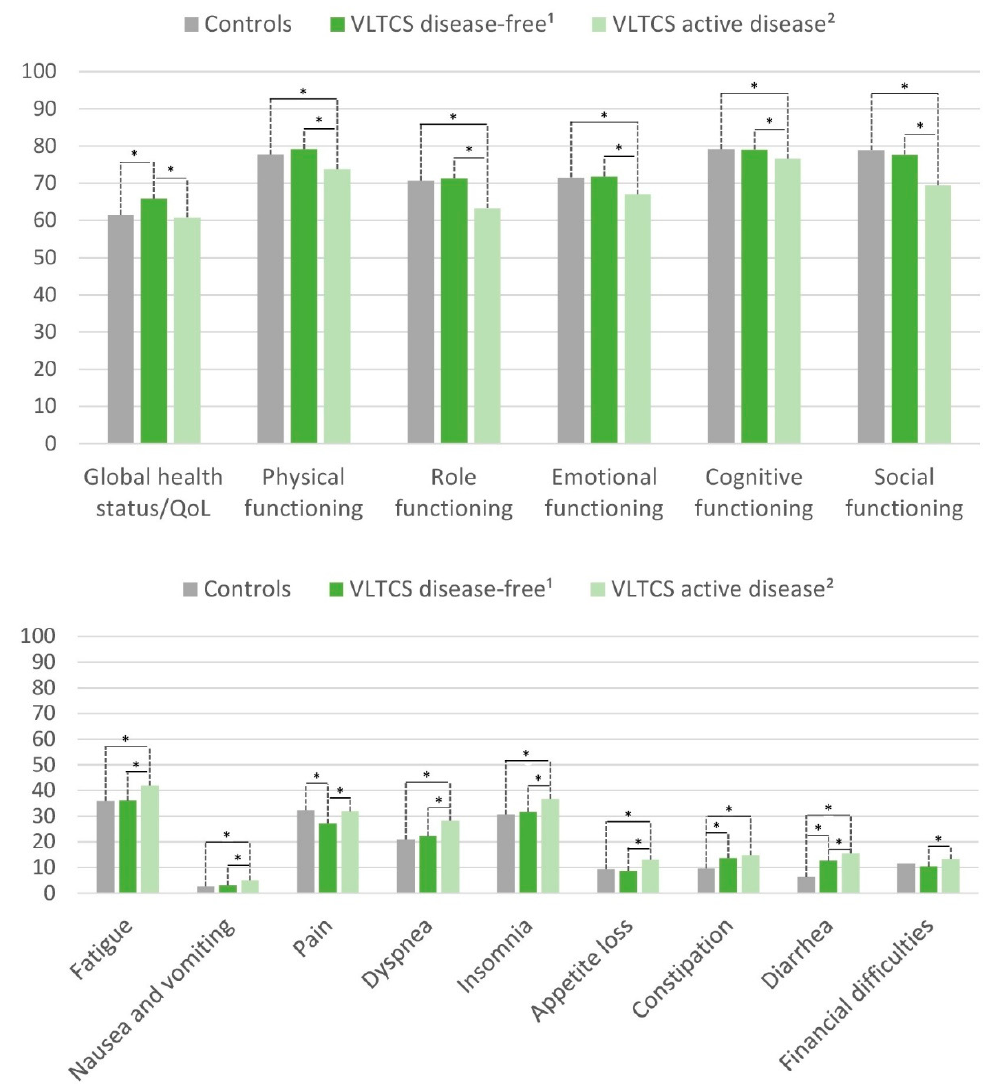
Figure 4. EORTC QLQ-C30 global health status/QoL, functioning scores, and symptom items and scores of long-term cancer survivors with and without active disease and of controls, adjusted for age, sex, and education. VLTCS, very long-term cancer survivors (recruited via population-based cancer registries). 1 Stage I–III at diagnosis and disease-free at follow-up according to self-report. 2 Stage IV at diagnosis or subsequent recurrence, metastasis, or second primary cancer. All differences were statistically significant ( p < 0.05) in global comparison. Asterisks (*) mark statistically significant differences in pairwise comparison ( p < 0.05). The spans of the lines indicate which subgroups differ significantly in pairwise comparison. For example, if the line spans three columns, it indicates a significant difference between controls and VLTCS with active disease. For example, global health status/QoL: Disease-free VLTCS report a higher QoL than controls and VLTCS with active disease, whereby controls and VLTCS with active disease are not significantly different. All results are based on 25 imputations of missing values.